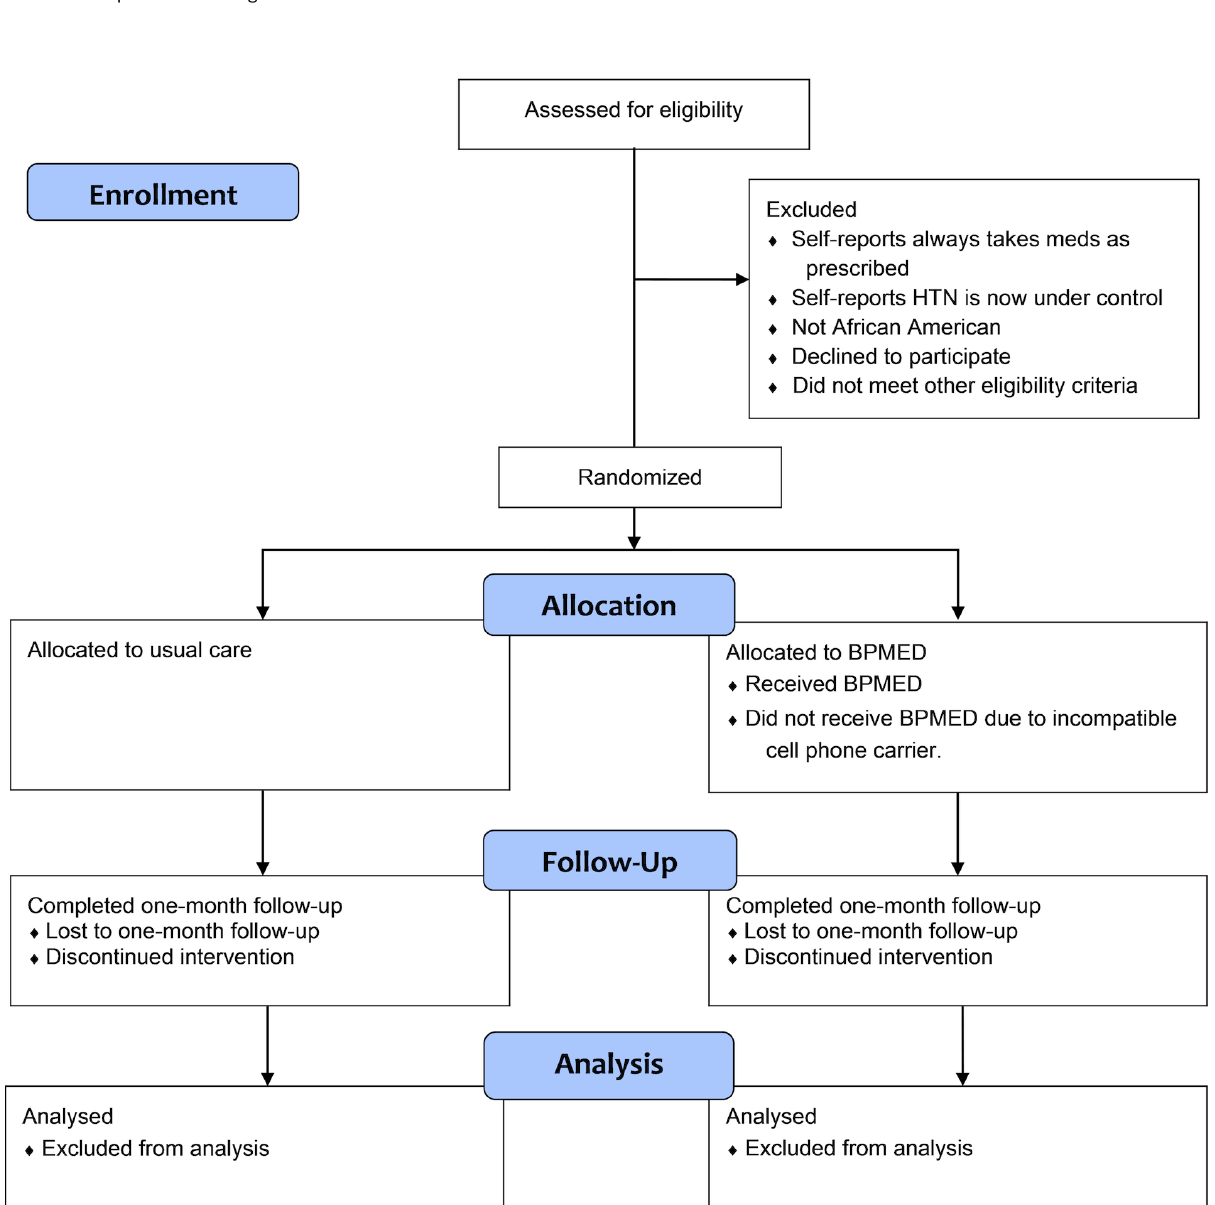
Figure 1. Participant flow through BPMED